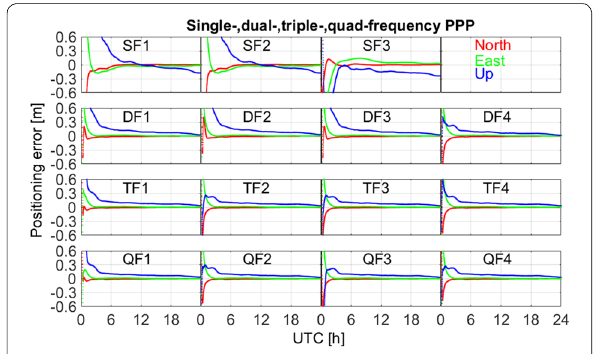
Fig. 3 Positioning errors of BDS single-, dual-, triple- and quad-frequency PPP at the iGMAS station KUN1 in the north, east and up components on DOY 16,